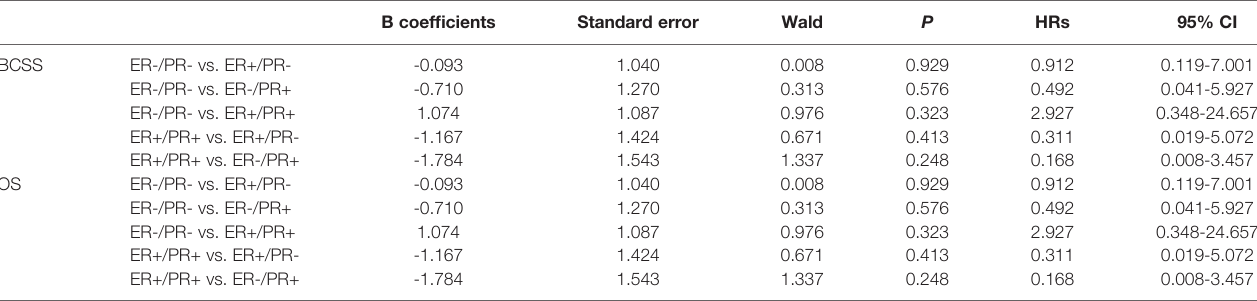
TABLE 4 | Multivariate analysis of BCSS and OS in 102 women with HER2-positive MBC. B coef fi cients